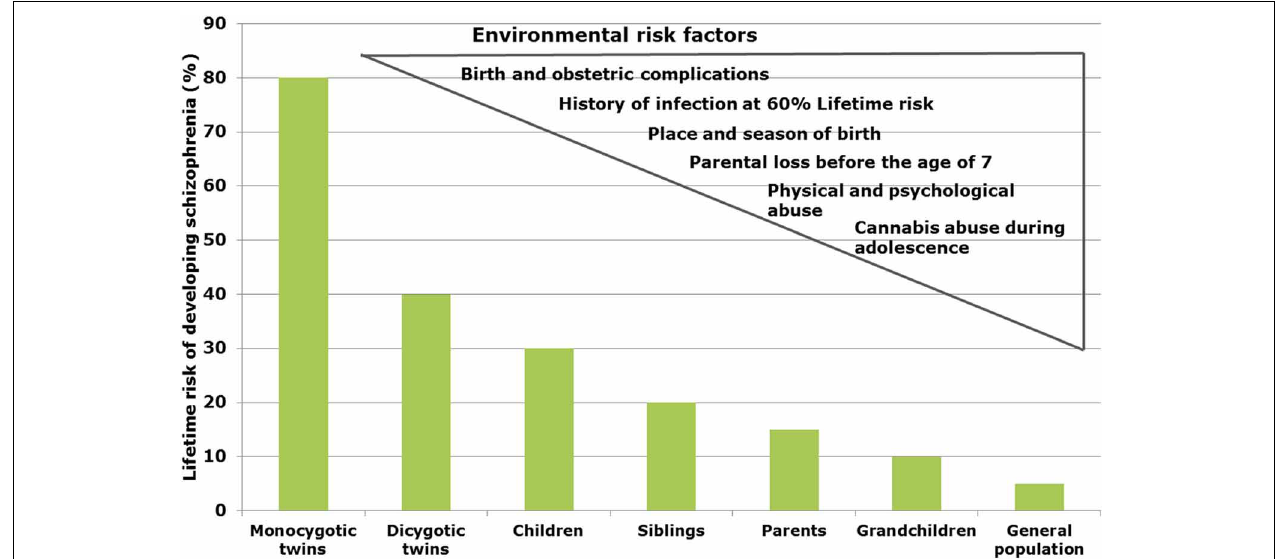
FIGURE 1 | Interacting risk genes and environmental factors contribute to increase the risk of schizophrenia. The figure shows the estimated heritability risk to develop schizophrenia as a factor of grade of next of kin.